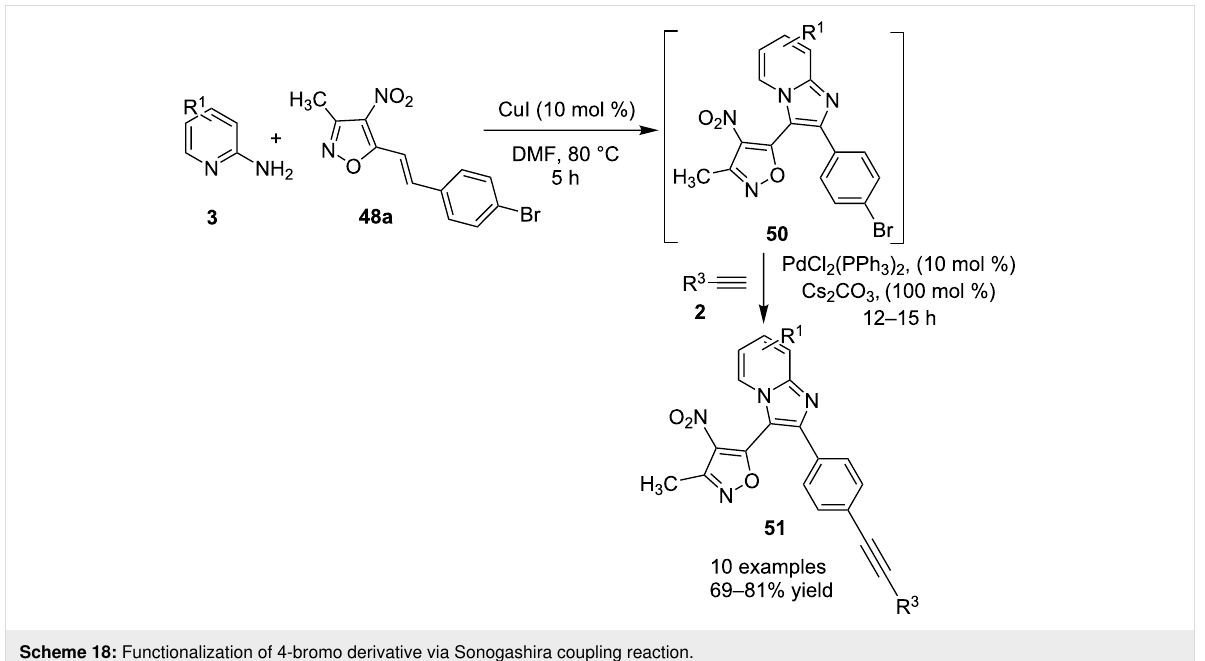
Scheme 18: Functionalization of 4-bromo derivative via Sonogashira coupling reaction.